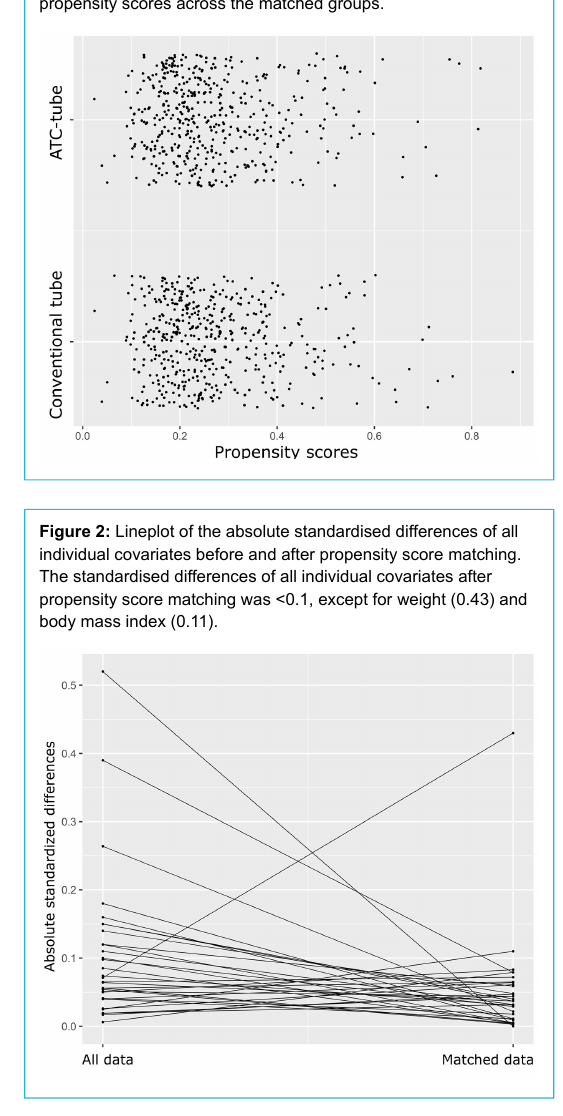
Figure 1: Jitter plot illustrating the distribution and overlap of propensity scores across the matched groups.